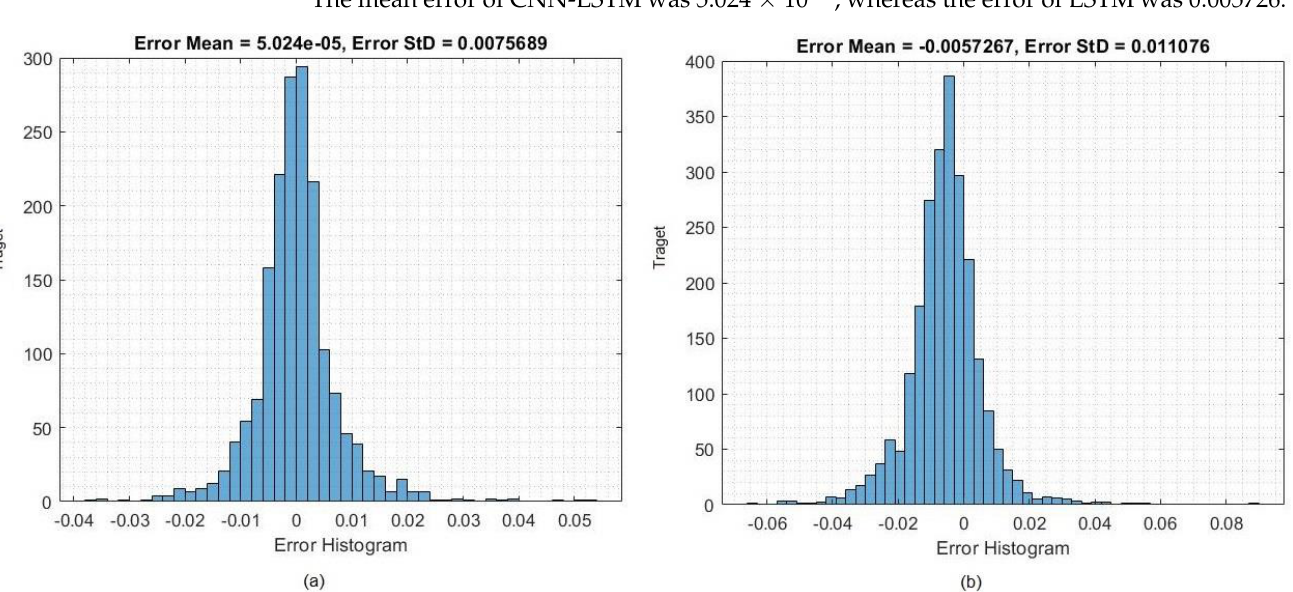
Figure 12. Rank correlation of the deep learning models ( a ) CNN-LSTM and ( b ) LSTM for predicting the Apple stock market closing price during the testing phase. Table 5. Deep learning results for predicting the closing price of Apple during the testing phase. Model